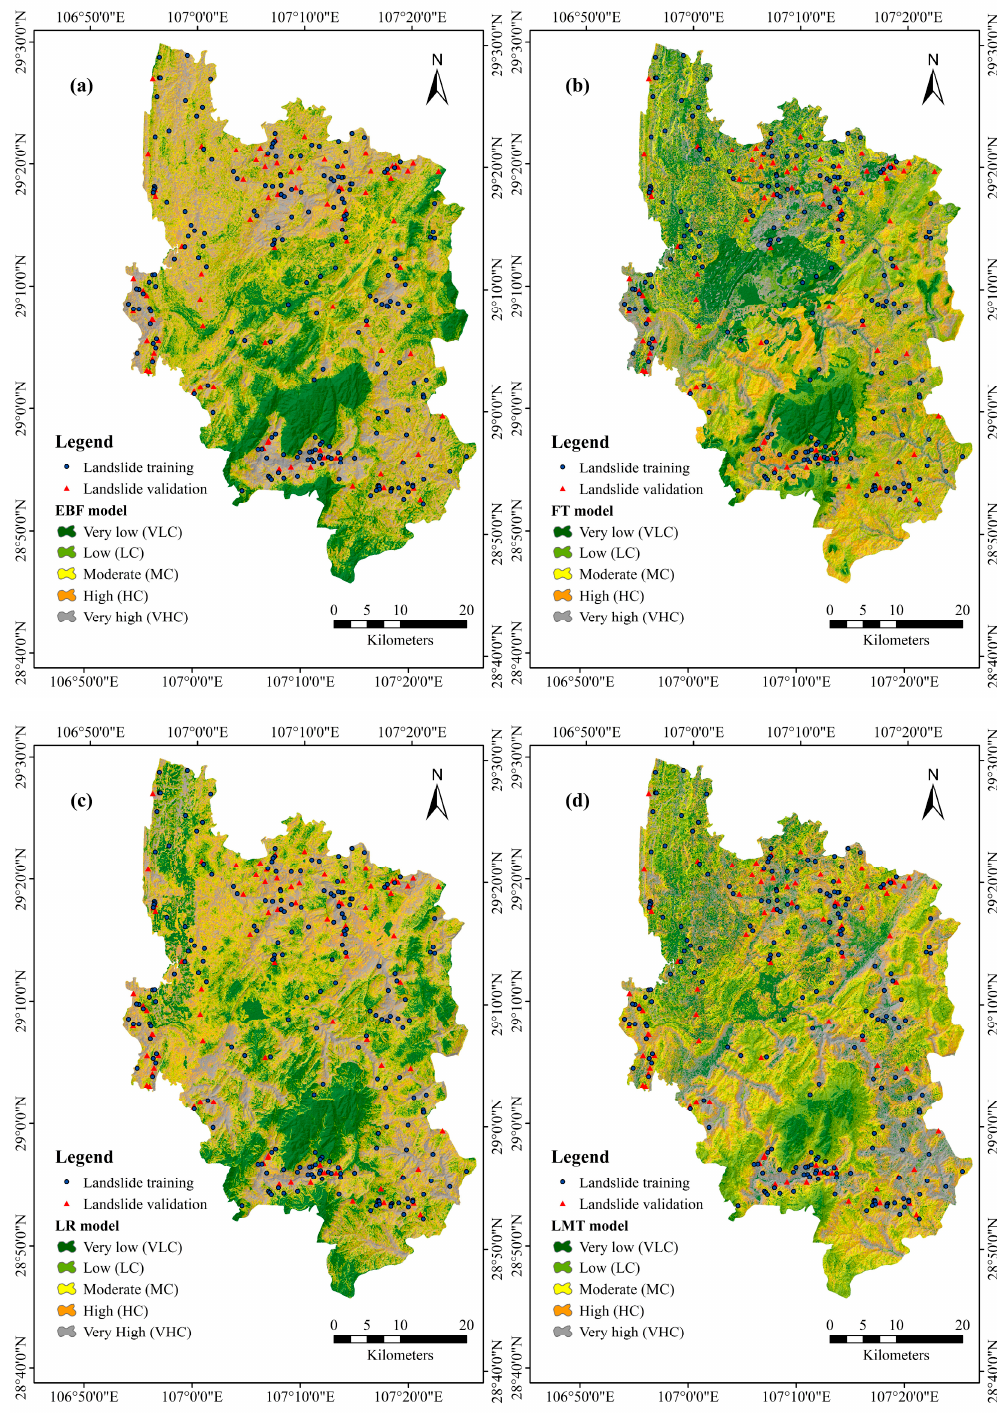
Figure 14. Landslide susceptibility maps derived from ( a ) the EBF model, ( b ) the FT model, ( c ) the LR model, and ( d ) the LMT model.